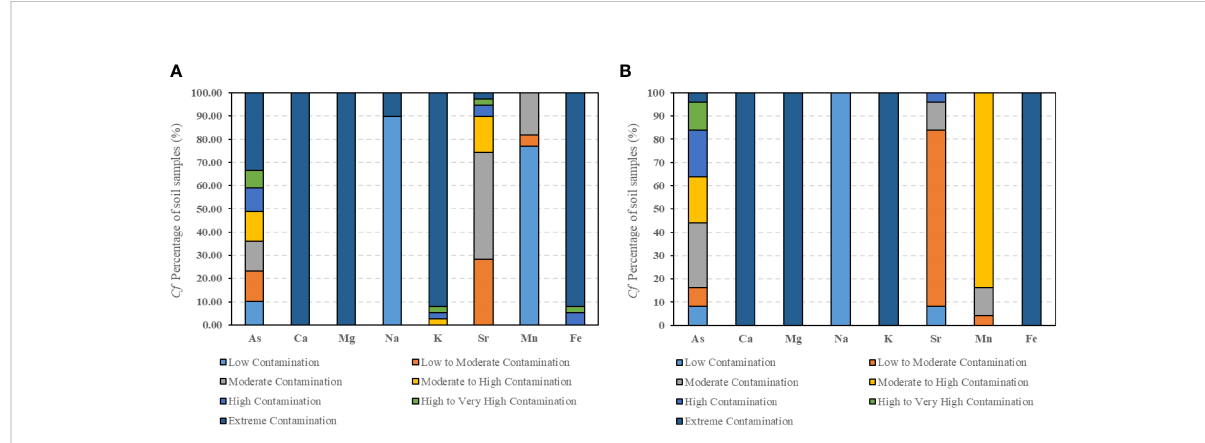
FIGURE 6 Contamination factor ( C f ) percentage of metals for (A) recreational soil and (B) agricultural soil at different contamination